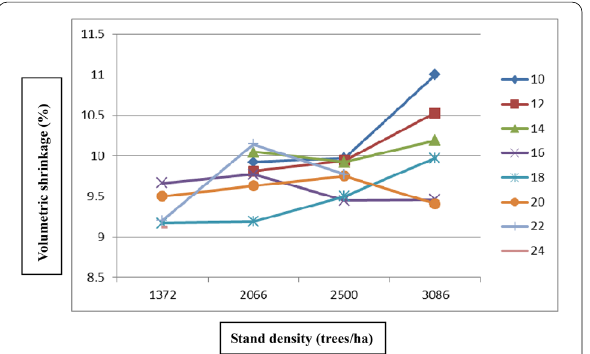
Fig. 6 Volumetric shrinkage in relation to stand density and DBH class